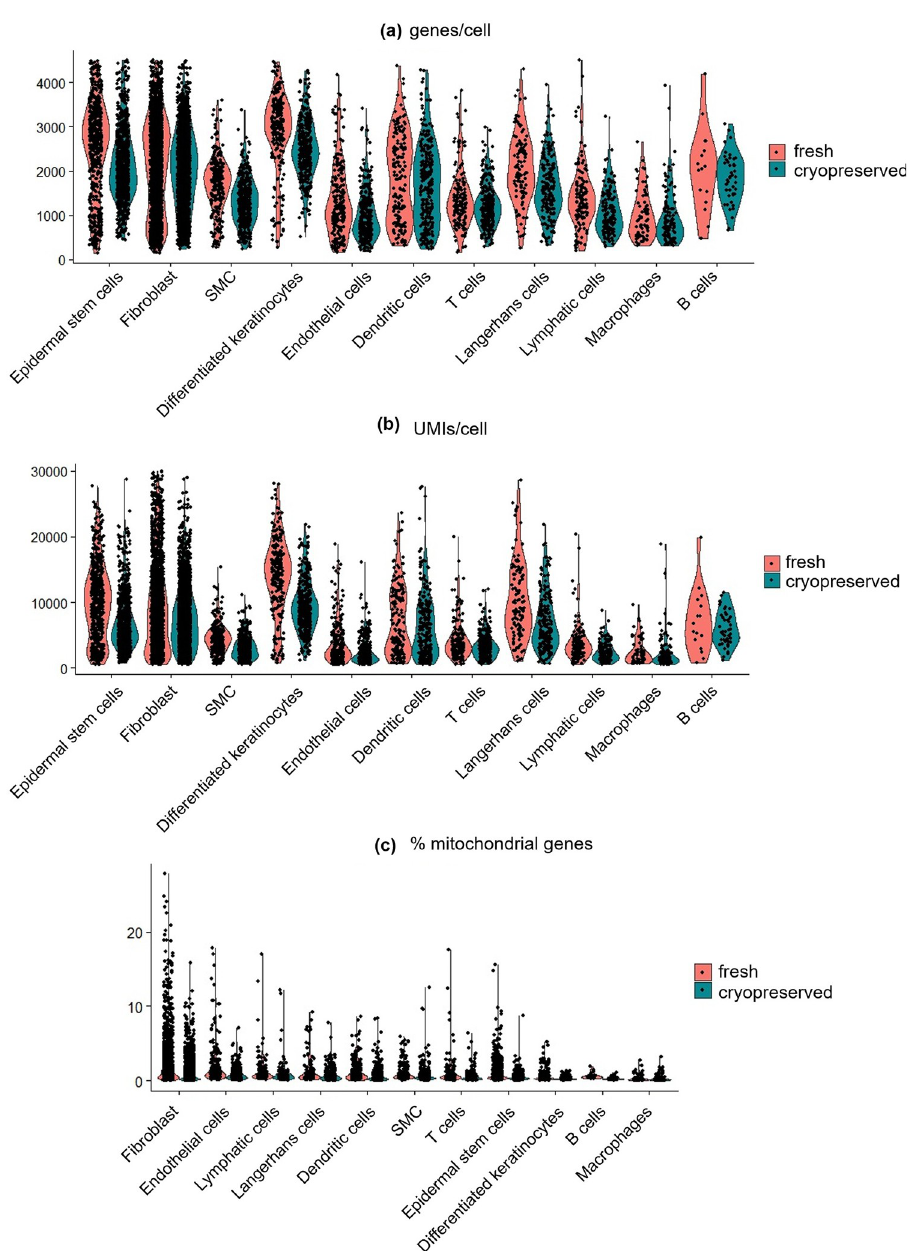
Fig 2. Fresh and cryopreserved cells have similar quality control parameters. The genes per cell (a), UMIs per cell (b), and % mitochondrial genes (c) in each cell of fresh and cryopreserved samples by cell type. Each dot represents one